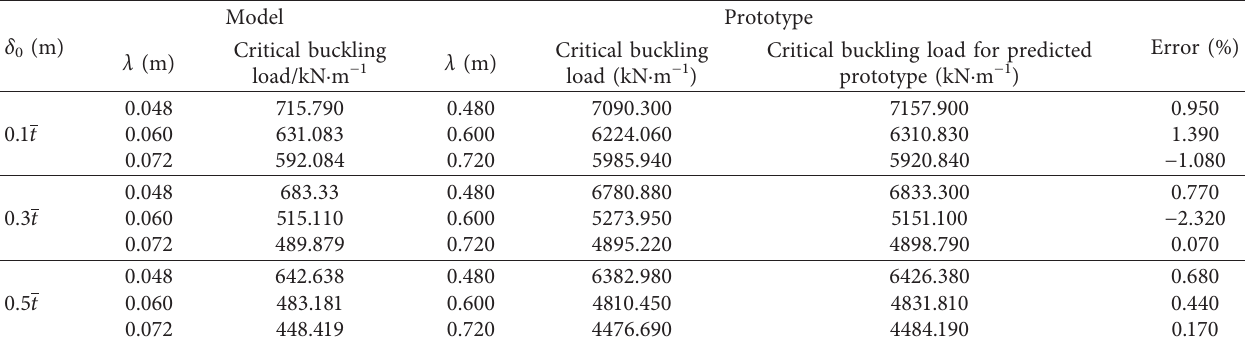
Figure 2: Longitudinal-ring stiffened cylindrical shell finite element model with dimple imperfection introduced (3x Table 5: Complete similitude simulation of nonlinear buckling of longitudinal-ring rectangular stiffened cylindrical shell under axial compression.